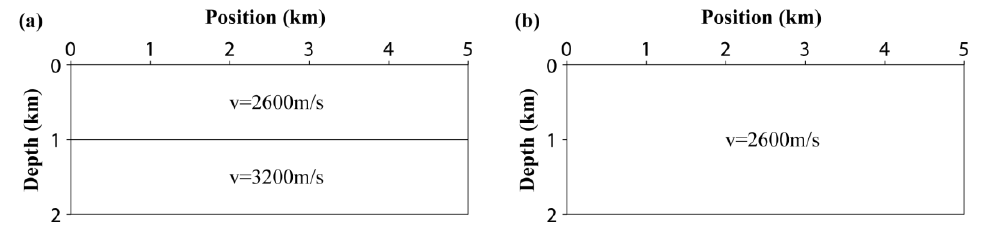
Figure 1. Two velocity models. ( a ) The two-layer model and ( b ) the constant velocity model.